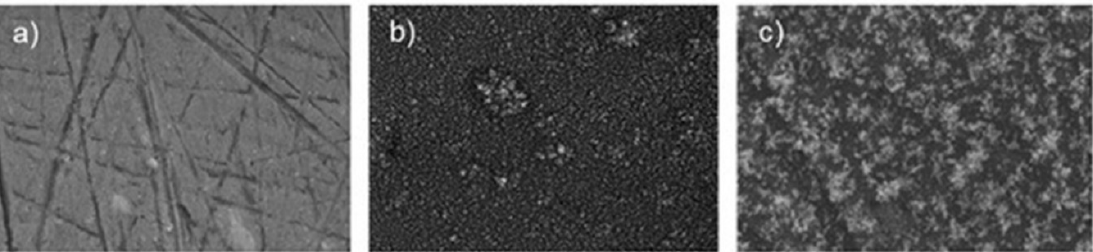
Figure 3. SEM images of ( a ) uncoated AA2024 sample, ( b ) TiO 2 -coated AA2024 with deposition time of 40 s and ( c ) TiO 2 -coated AA2024 with deposition time of 80 s